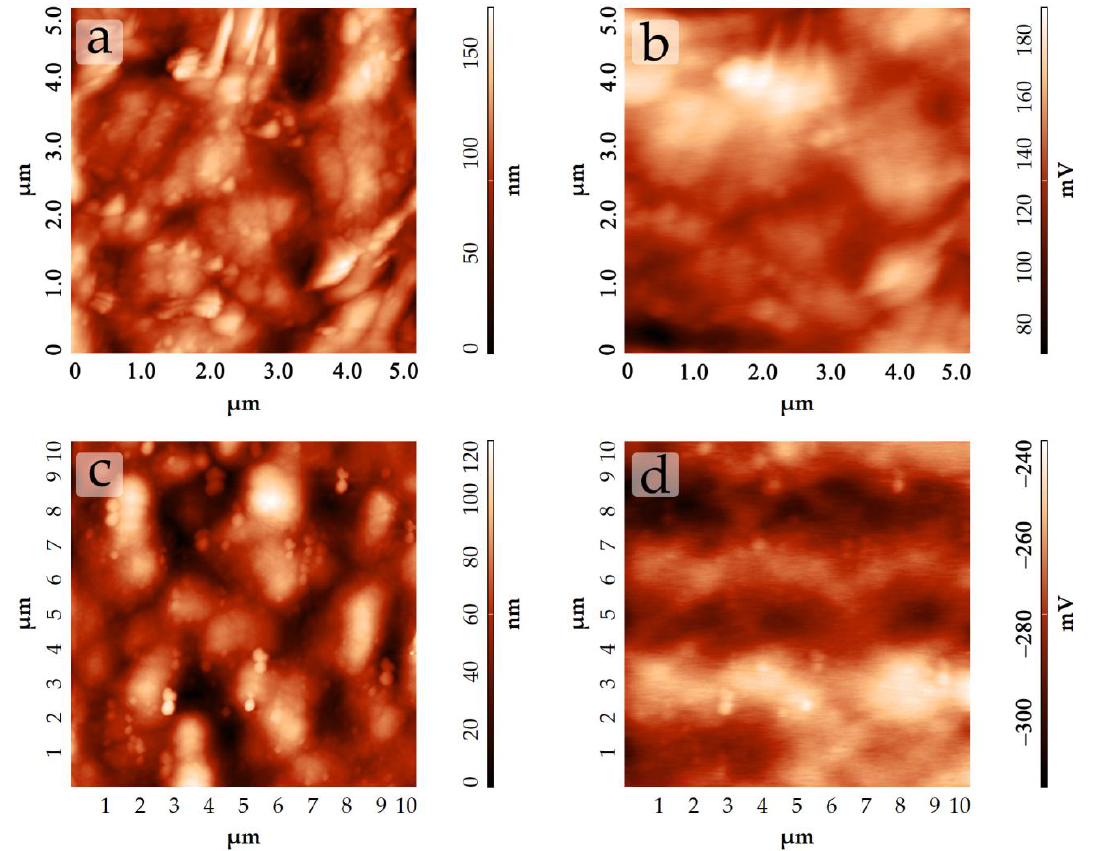
Figure 5. The AFM results: topography ( a ) and surface potential distribution map ( b ) of Ti 2 CT x /TiO 2 MXene film oxidized at 316 °C; topography ( c ) and surface potential distribution map ( d ) of Ti 2 CT x /TiO 2 film oxidized at 447 °C.